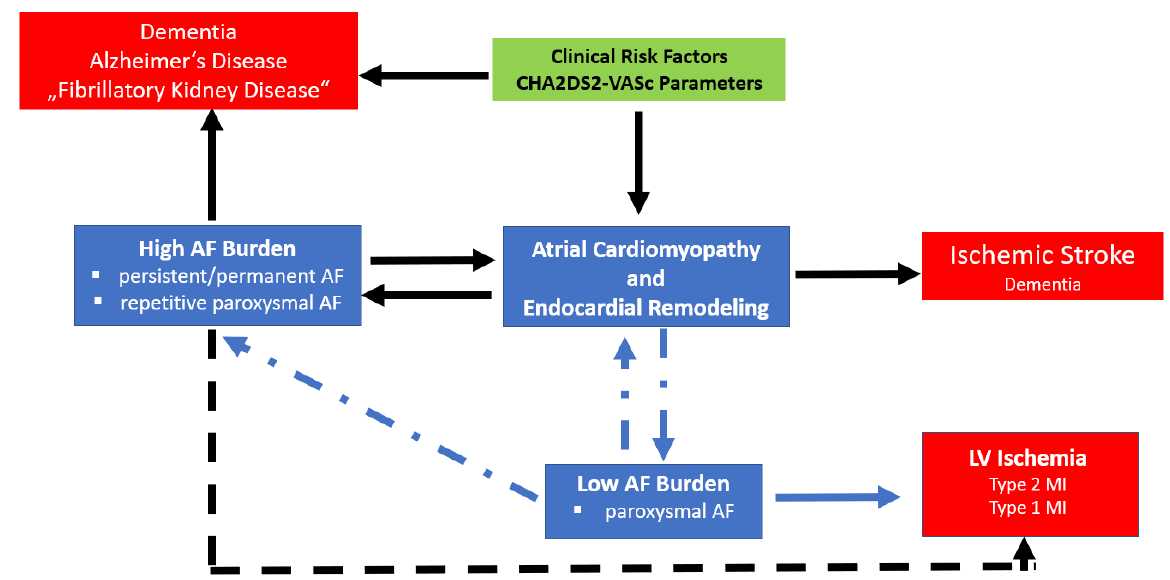
Figure 3. Impact of type of atrial fibrillation (paroxysmal AF, persistent AF) on clinical outcome. The recent hypothesis is that the burden of AF contributes to differences in the occurrence of specific clinical events such as cognitive decline, stroke, or myocardial infarction. At the molecular level, differences can be explained by activation of a difference in cellular oxidative stress pathways, which are regulated or counter-regulated during the course of an AF episode. Diseases or conditions such as diabetes mellitus, history of stroke, heart failure, ageing, sex, and vascular diseases are summarized in the CHA2DS2VASc Score.